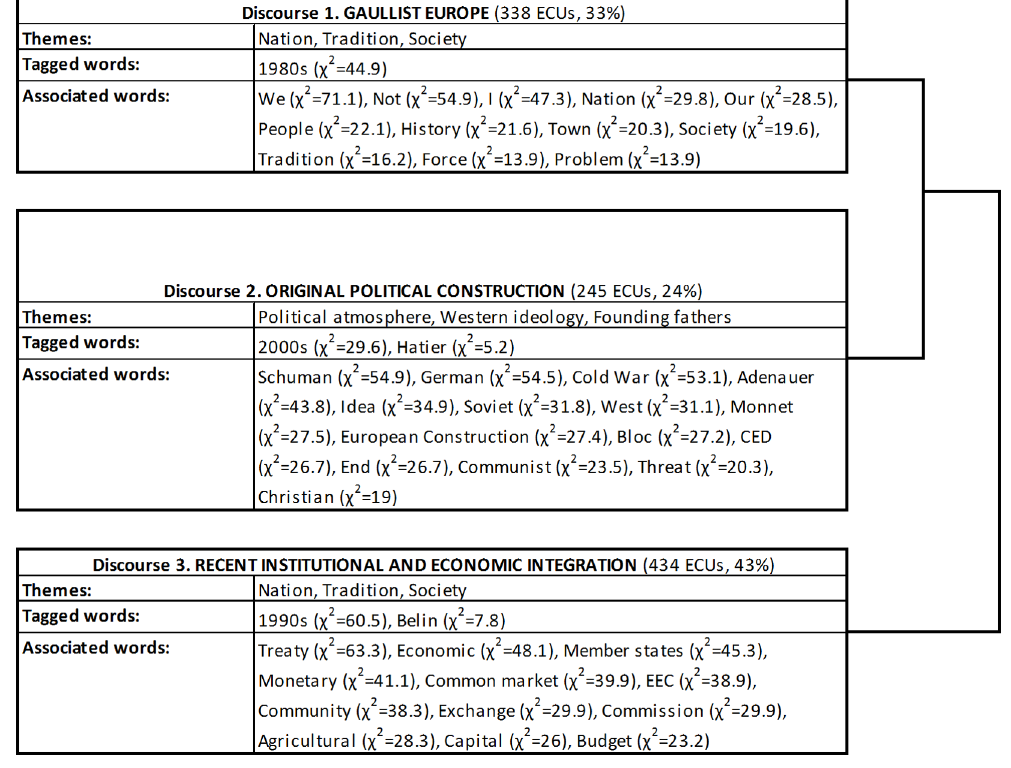
Figure 1. The results of ALCESTE analysis in French